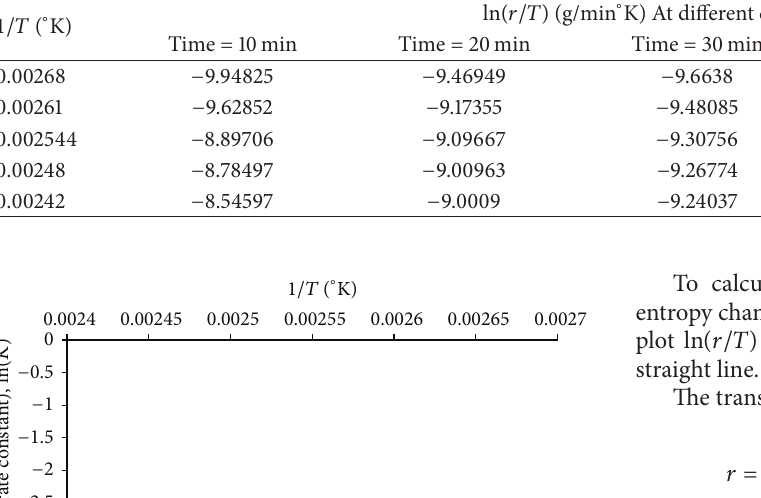
Table 3: ln( 𝑟/𝑇 ) (g/min ∘ K) of recycled PVC resin at different times (min) and at different temperatures (100–140 ∘ C). 1/𝑇 ( ∘ K)